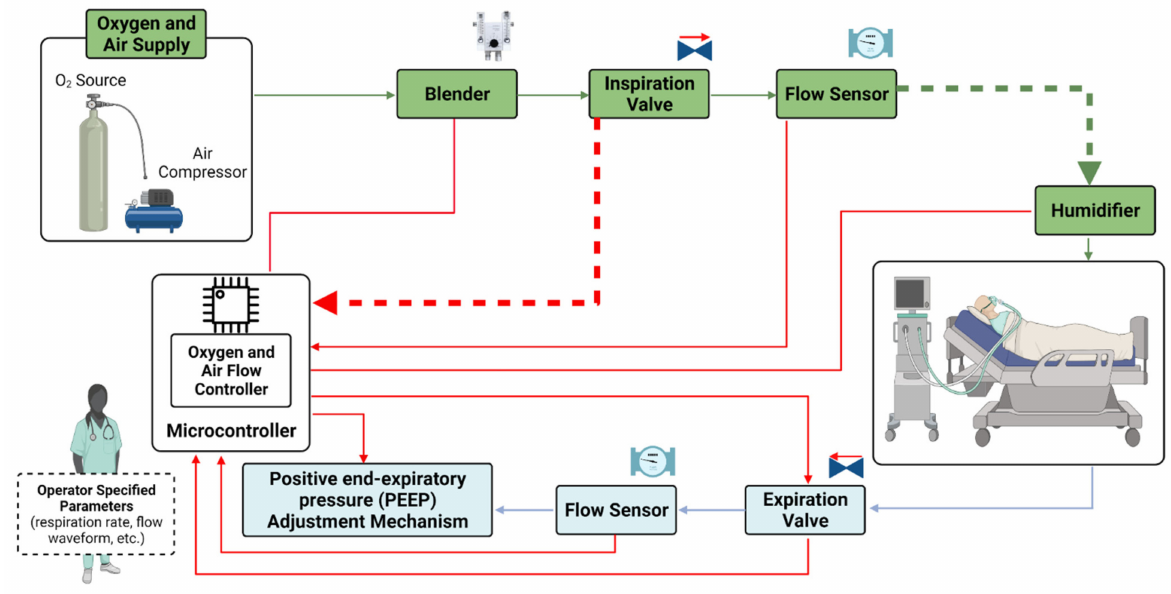
Figure 2. Block diagram of mechanical ventilator showing main parts and operation principle (Adapted from Ref.